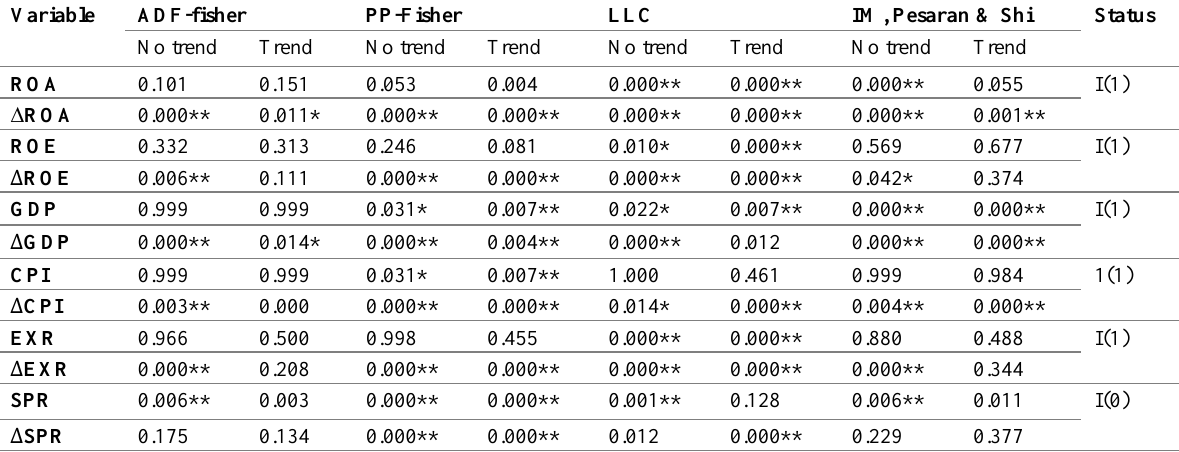
Table 1: Panel unit root tests